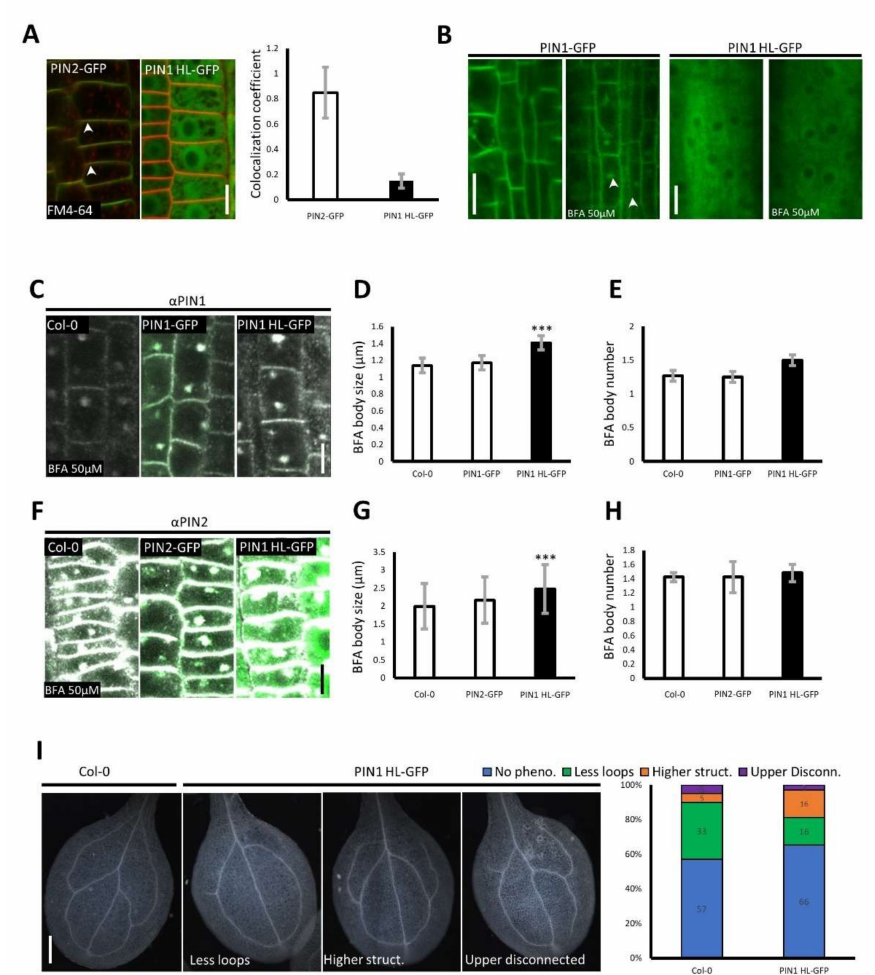
Figure 3. PIN1 HL–GFP overexpression alters the BFA-visualized PIN accumulation and causes defects in cotyledon vasculature development. ( A ) Representative confocal images of root epidermal cells expressing either PIN2–GFP or PIN1 HL–GFP and stained with FM4 − 64. Arrowheads indicate colocalization (yellow) of GFP (green) and FM4–64 (red) signal in PIN2–GFP control while no obvious colocalization is observed for PIN1 HL–GFP. The right panel represents colocalization coefficient quantification. The scale bar is equal to 5 µ m. ( B ) Representative confocal images of root vasculature cells visualizing PIN1–GFP and PIN1 HL–GFP before and after BFA (50 µ M). One-hour BFA treatment does not reveal the characteristic (arrowheads) BFA-induced aggregates in the PIN1 HL–GFP expressing line. Scale bars represent 10 µ m. ( C – E ) Immunolocalization of PIN1 in root vasculature in Col–0, PIN1–GFP, and PIN1 HL–GFP after 1 h of 50 µ M BFA treatment indicates significantly increased BFA body size in the PIN1 HL–GFP line. The right panel depicts the quantification of BFA body size ( D ) and number ( E ). Error bars represent standard deviation while the two-tailed t -test marks significance (*** p < 0.005). ( F ) Immunolocalization of PIN2 in epidermal cells in Col–0, PIN2–GFP, and PIN1 HL–GFP after 1–h and 50 µ M BFA treatment indicates a bigger BFA body size in the PIN1 HL–GFP expressing line. GFP signals are represented in green while the immuno-stain signals are white. Quantification of BFA body size ( G ) and number ( H ) are depicted and evaluated statistically analogically as for PIN1 above ( D , E ). Scale bars for panels ( C , F ) equal 5 µ m. ( I ) Representative images of cotyledon venation pattern in Col–0 and PIN1 HL–GFP seedlings. The right panel represents the quantification of venation changes in the PIN1 HL–GFP line compared to Col–0 (n < 80 for each line). Scored phenotypes: no phenotype, less loops, higher structures, upper disconnected. Scale bar: 200 µ